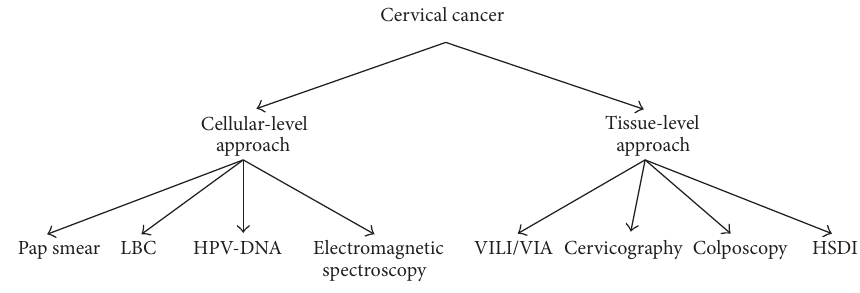
Figure 1: Taxonomy of cervical cancer screening. Table 1: Comparison of the ability of the manual cervical screening